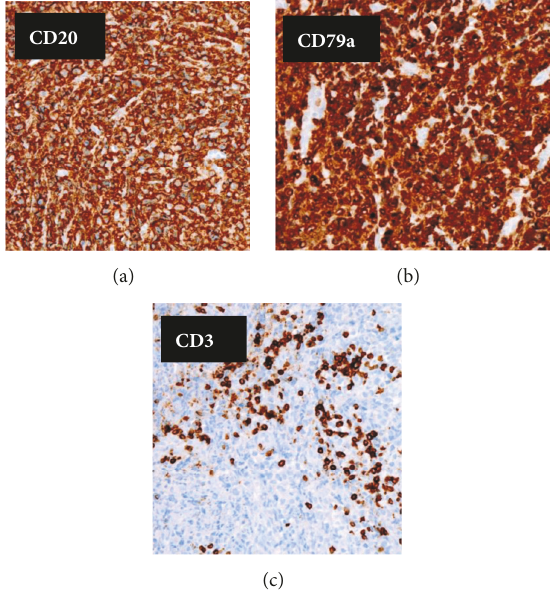
Figure 7: Immunohistochemistry staining. CD20 and CD79a: Strong positive cytoplasmic staining indicative of lymphoid cells of B-type lineage (a, b). CD3: scant scattered reactive T-cells in background